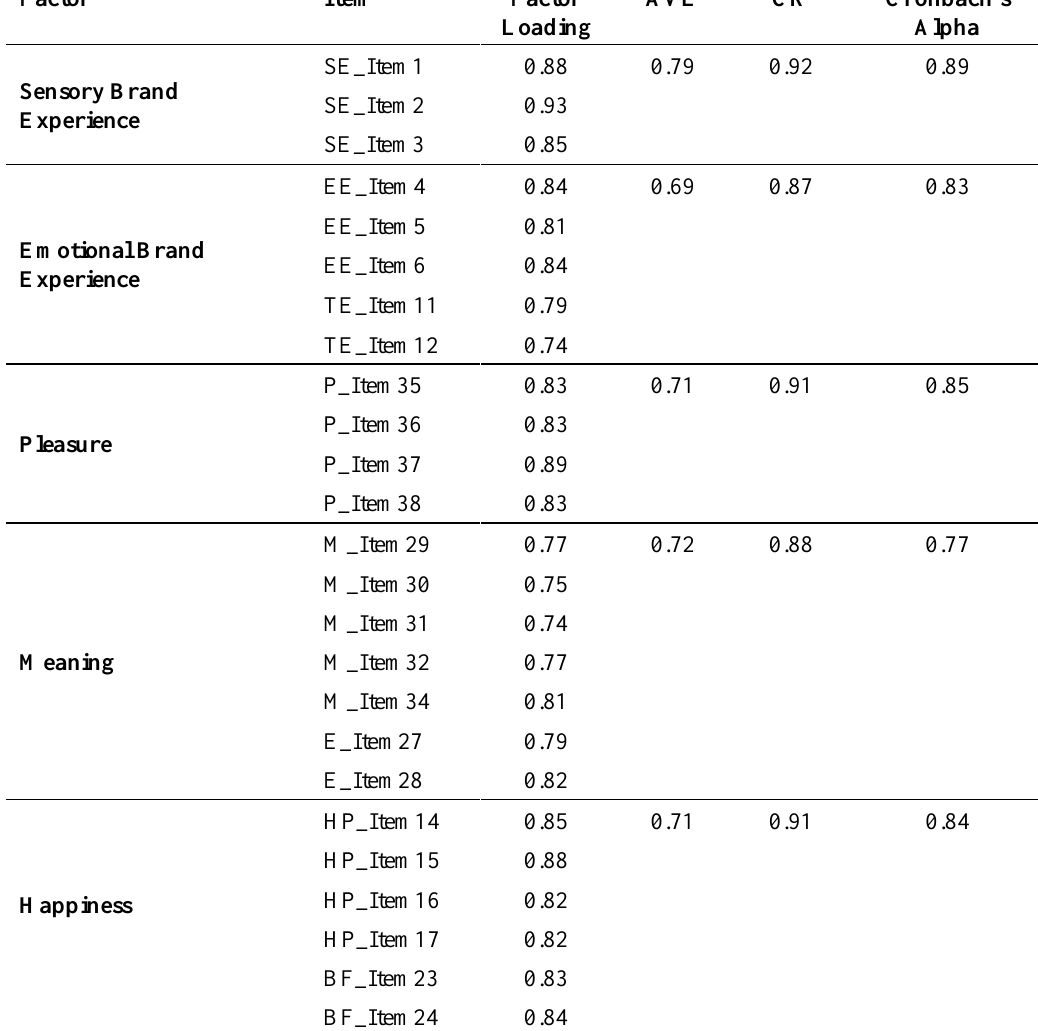
Table.3. Construct Validity and Reliability